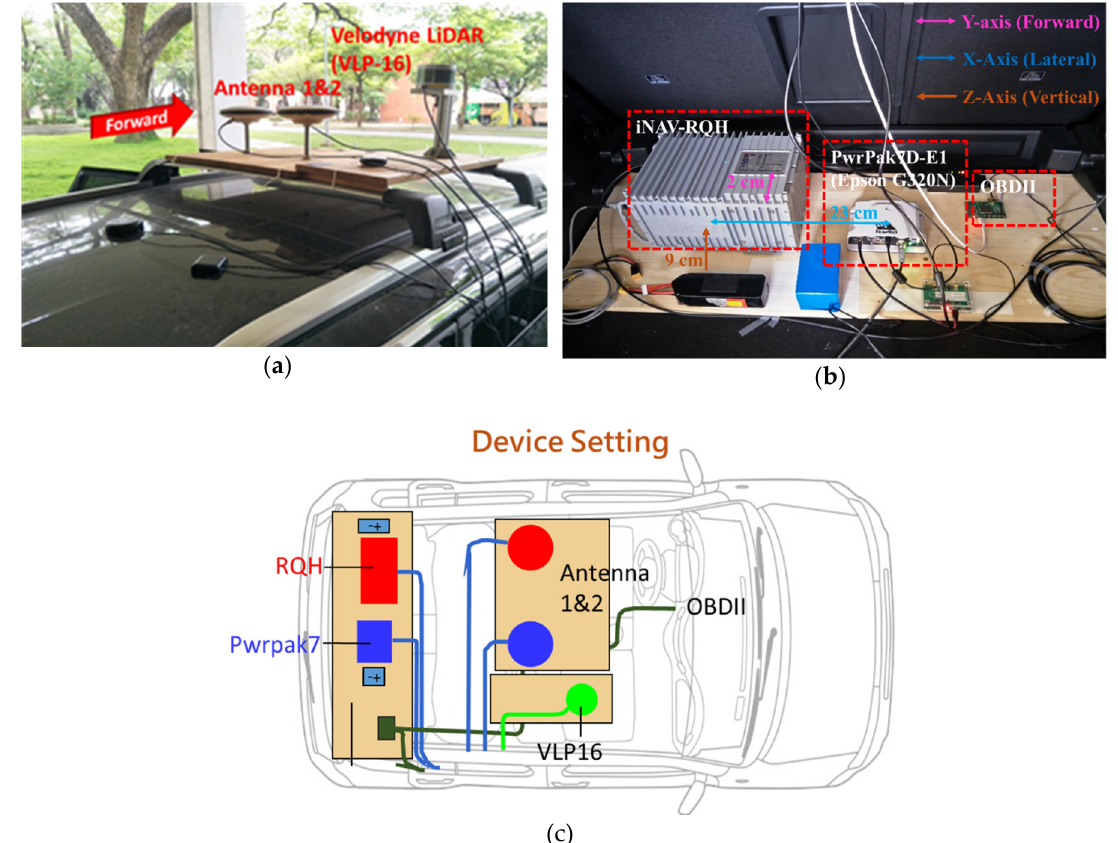
Figure 7. Configuration of the designed land vehicle: ( a ) GNSS antennas and LiDAR, ( b ) inertial measurement units (IMUs), ( c ) device setting. Table 1. Specifications of the iNAV-RQH (reference system) and Epson G320N.